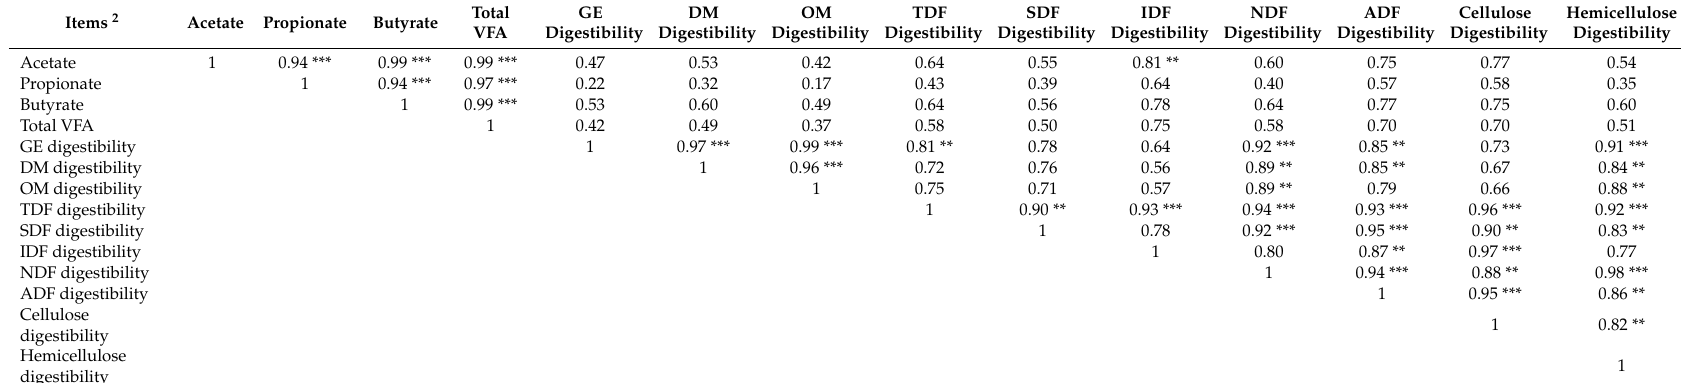
Table 7. Coe ffi cients of correlation among the ATTDs of non-fibrous components or intact fermentation of fiber components and VFA concentration in feces of pigs 1